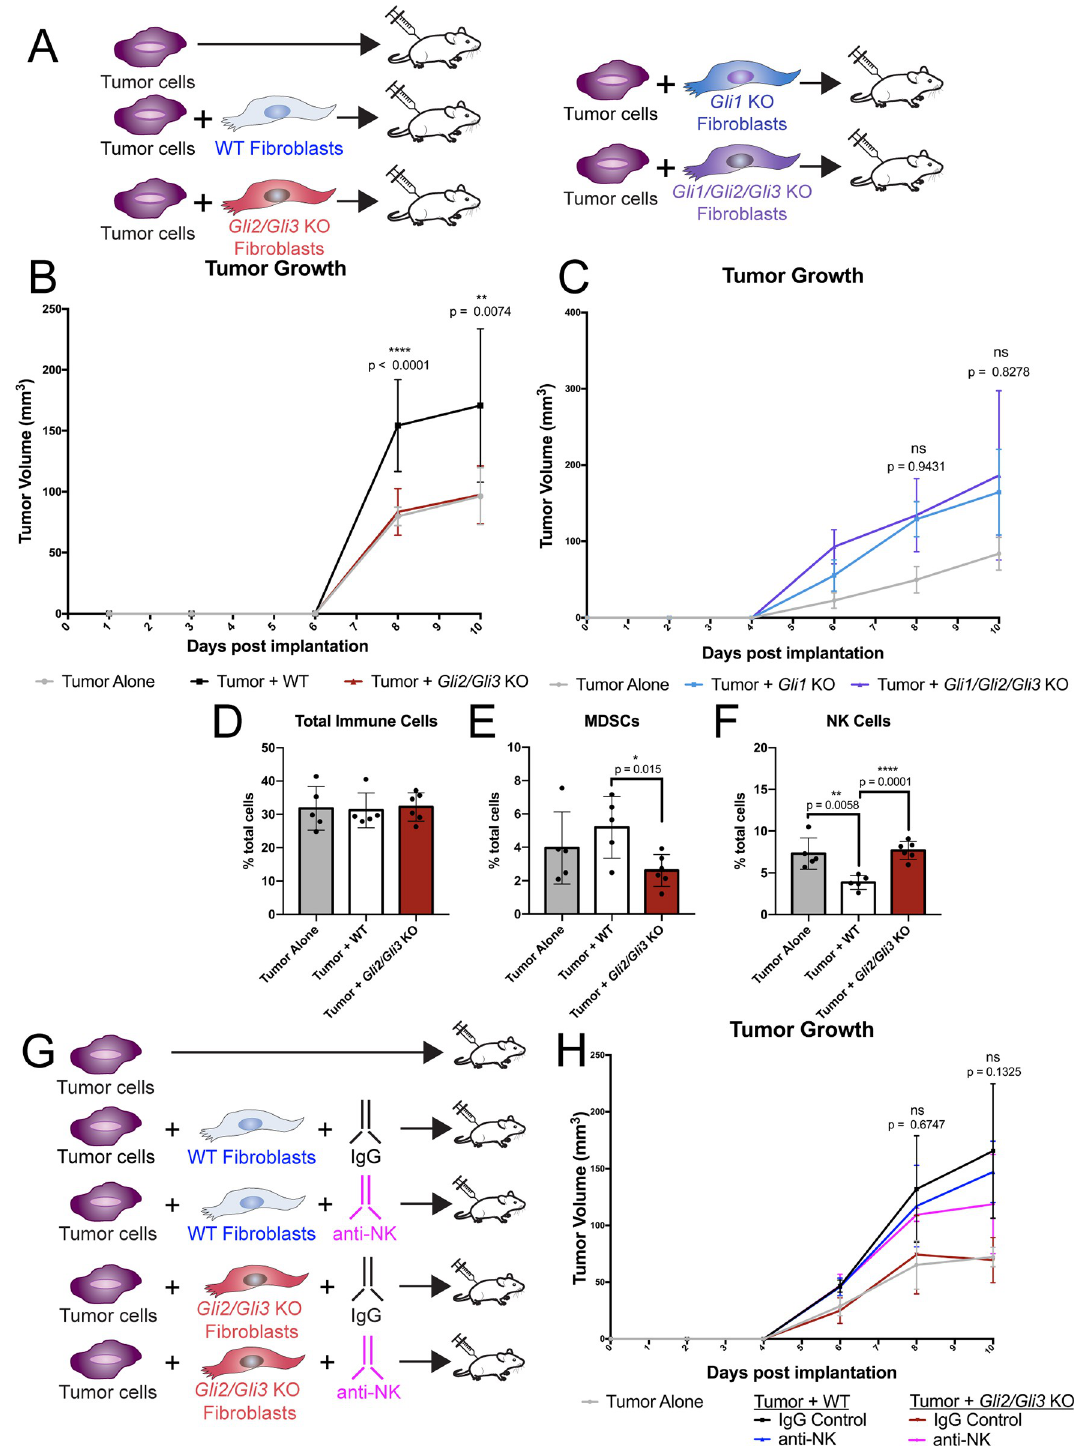
Fig 5. Loss of Gli2 and Gli3 reduces tumor growth through the recruitment of NK cells. A ) Cartoon depicting experimental strategy. Tumor cells were injected subcutaneously either alone or in combination with pancreatic fibroblasts into nude mice. ( B-C ) Volume (mm 3 ) of implanted tumors over time. Tumor cells were injected alone (gray), or co-injected with WT (black), Gli2/3 KO (red), Gli1 KO (blue), or Gli1/Gli2/Gli3 KO (purple) pancreatic fibroblasts. Displayed p-values compare Gli KO fibroblasts to their corresponding parental line control. ( D-F ) Flow cytometry analysis of total immune cells ( D ), MDSCs ( E ), or NK cells ( F ) in